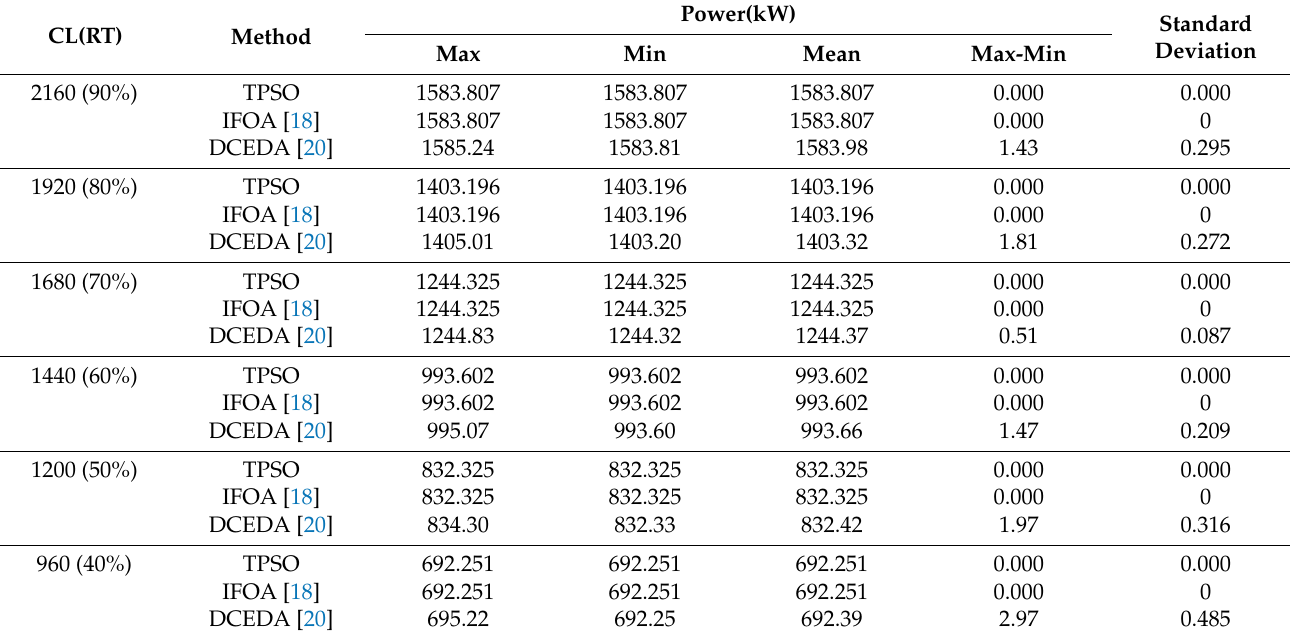
Table 18. Comparison of stability yielded by TPSO, IFOA and DCEDA in Case